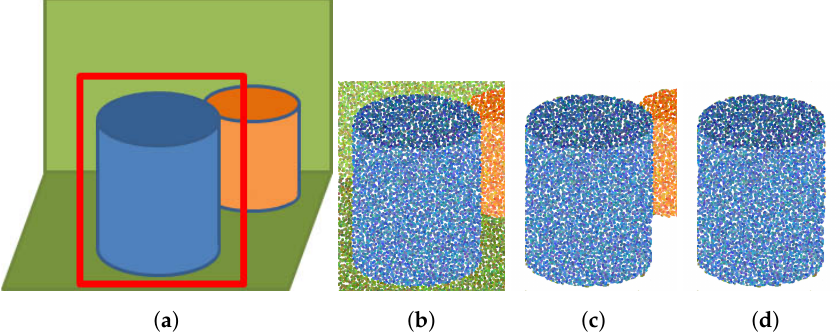
Figure 4. Per-object point cloud generation process. ( a ) RGB image with the bounding box, ( b ) Point cloud generated from the cropped depth image, ( c ) Point cloud after surface removal and ( d ) Per-object point cloud after